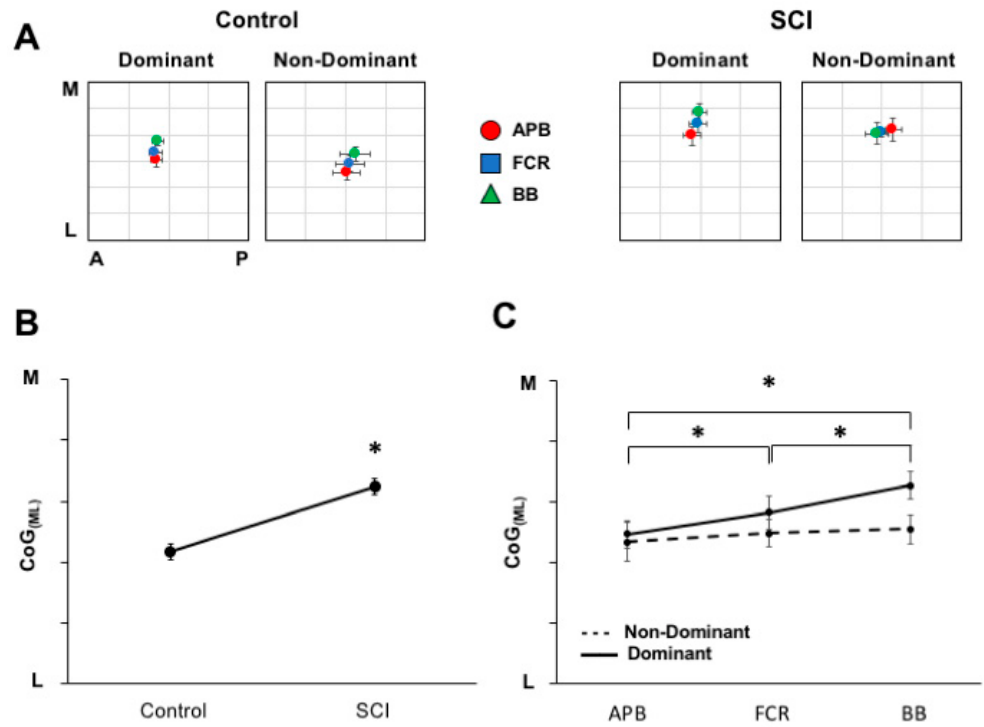
Figure 5. Differences in cortical territory somatotopy between hemispheres and groups. ( A ) The pooled CoG across muscles for each group for each hemisphere. ( B ) The medio-lateral CoG positions across groups demonstrates the main effect of group. The SCI group shows medially shifted muscle representations compared to controls ( p = 0.041). ( C ) Differences across hemispheres and muscles were seen such that a somatotopic progression is observed in the dominant hemisphere with biceps brachii (BB) located medial to flexor carpi radialis (FCR) ( p < 0.001) and APB ( p = 0.01), and FCR is medial to APB ( p = 0.032). * indicates a significant difference between muscles of the dominant hemisphere.